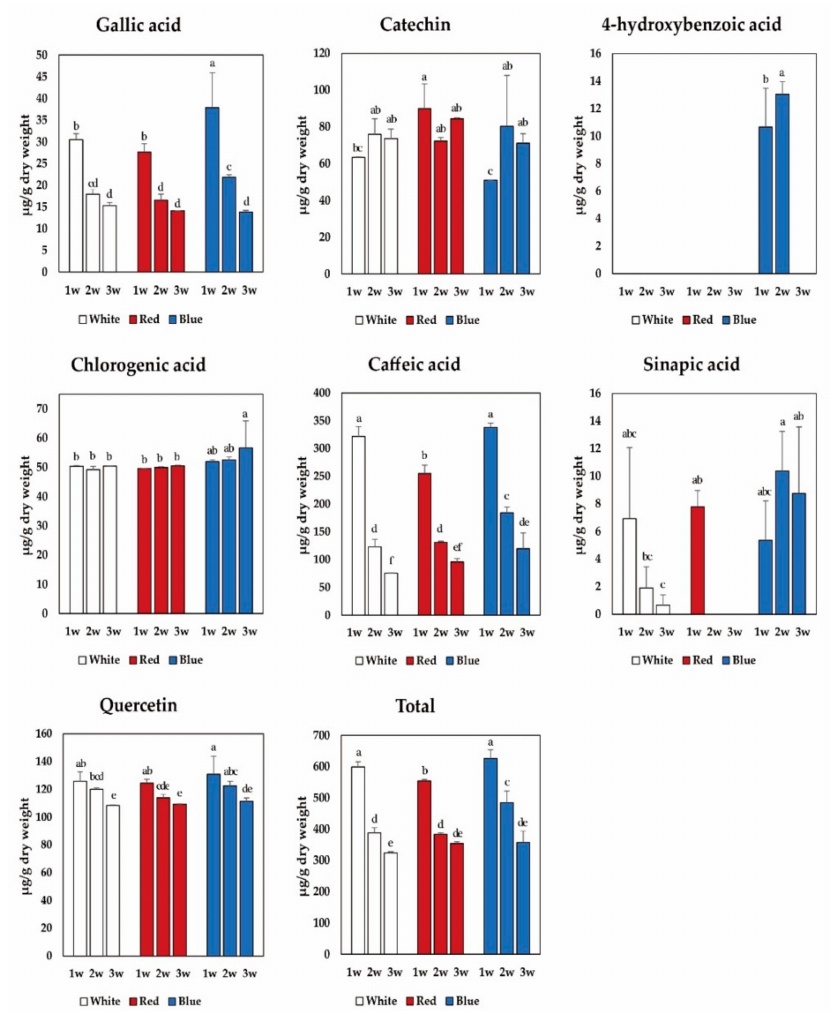
Figure 4. Phenolic contents of B. juncea sprouts grown under LED illumination of varying duration. Di ff erent letters indicate a significant di ff erence among means, applying Duncan’s multiple range test ( p < 0.05), and bars represent standard deviation of the